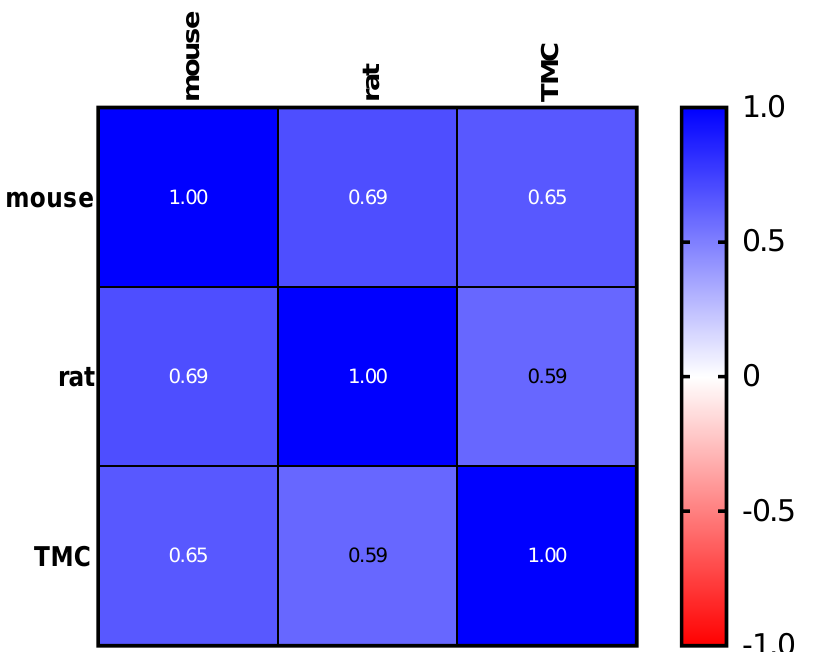
Figure 3. Spearman correlation heat map based on the LD50 dataset obtained from the literature (mice and rats) and experimental LD50 data obtained using TMC model. Spearman r is reported in white. p -value < 0.05 was considered significant (TMC vs. rats, p = 0.017; TMC vs. mice, p = 0.010).